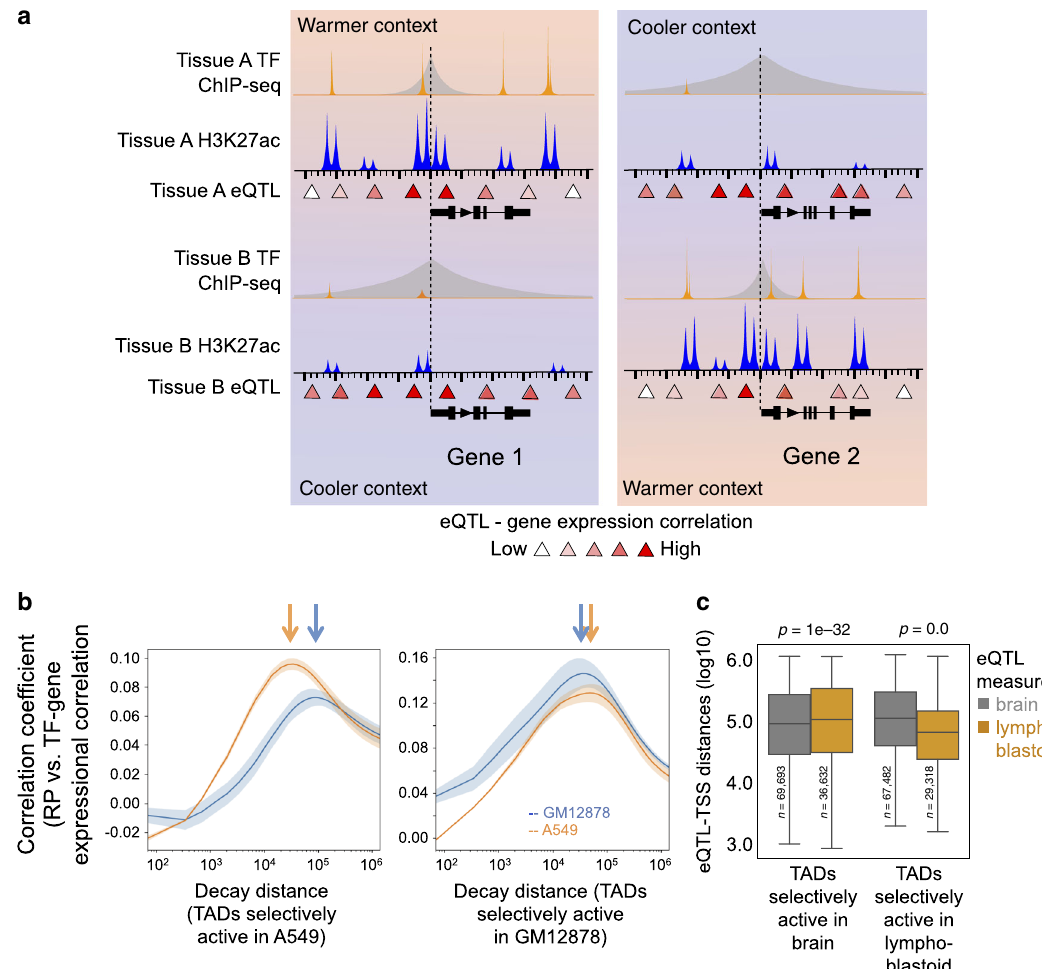
Fig. 5 Regulatory decay distances change with TAD activity and chromatin state. a Schematic illustration of TF regulatory decay and eQTL-TSS distances decreasing with increasing TAD activity. b The regulatory decay distance of RELA gets shorter as TADs become more active. RELA is expressed in both lymphoblastoid and lung, which possess distinct distributions of active TADs. In the TADs that are more active in lung than in lymphoblastoid cells, the lung-speci fi c RELA regulatory distance is shorter than the lymphoblastoid-speci fi c RELA regulatory distance (left). On the other hand, in the TADs that are more active in lymphoblastoid cells than in lung, the lymphoblastoid-speci fi c RELA regulatory distance is shorter than the lung-speci fi c RELA regulatory distance (right). The lung-speci fi c RELA regulatory decay distance is estimated using RELA ChIP-seq in A549 lung cells and GTEx lung expression data, and the lymphoblastoid-speci fi c RELA regulatory decay distance is estimated using RELA ChIP-seq in GM12878 and GTEx lymphoblastoid expression data. c GTEx eQTL-TSS distances are shorter in the TADs that are more active in the tissues in which the eQTLs are measured. As in b , the distribution of GTEX eQTL-TSS distances measured in brain (gray) or lymphoblastoid (orange) were compared in TADs that are more active in brain than in lymphoblastoid cells and vice versa. Left: TADs more active in brain than in lymphoblastoid. Right: TADs more active in lymphoblastoid than in brain. The different log- transformed eQTL-TSS distances in individual groups of TADs were compared using the two-sided Student ’ s t test. The box plot extends from the lower to the upper quartile values of the data, with a line at the median. The whiskers extend from the box to show the range of the data. Source data are provided as a Source Data fi